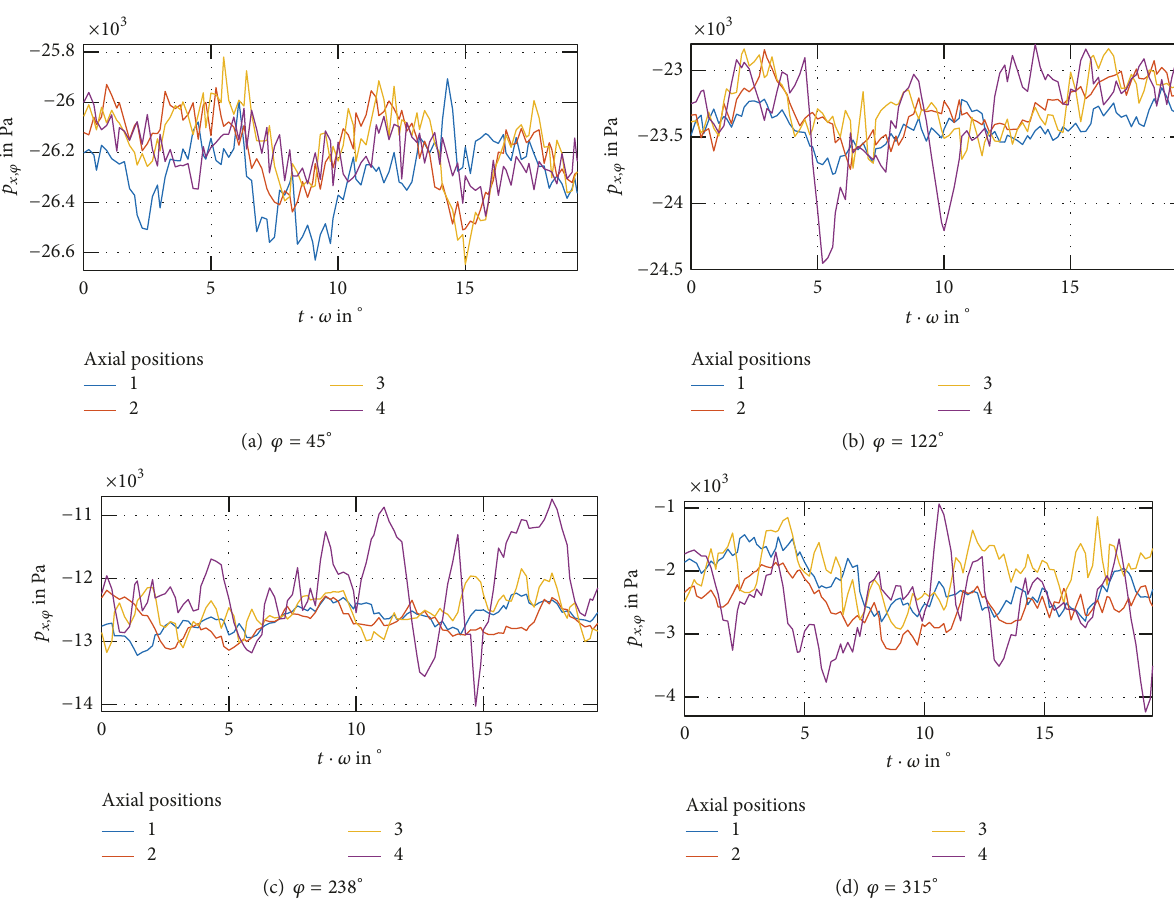
Figure 16: Pressure at a rotational speed of 50Hz and Δ𝑝 12, red = 28,000Pa measured at the unsteady measurement positions. The term 𝑡 ⋅ 𝜔 was chosen instead of 𝜑 to describe the rotation of the